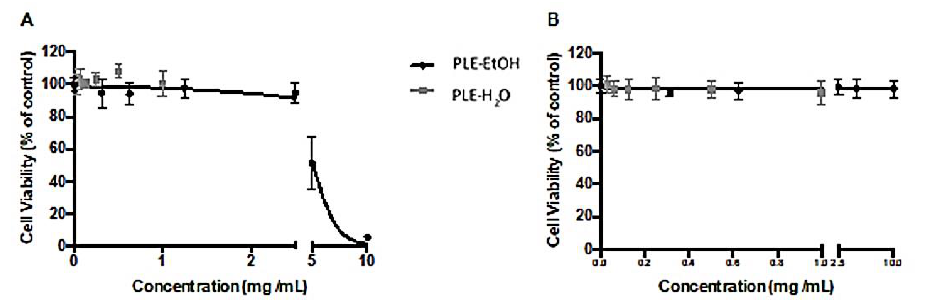
Figure 3. Dose-response curves of strawberry extracts. Antiproliferative ( A ) and cytotoxicity ( B ) effects using HT29 and Caco-2 cell lines, respectively. Results are expressed in terms of mean ± SD performed in triplicate.